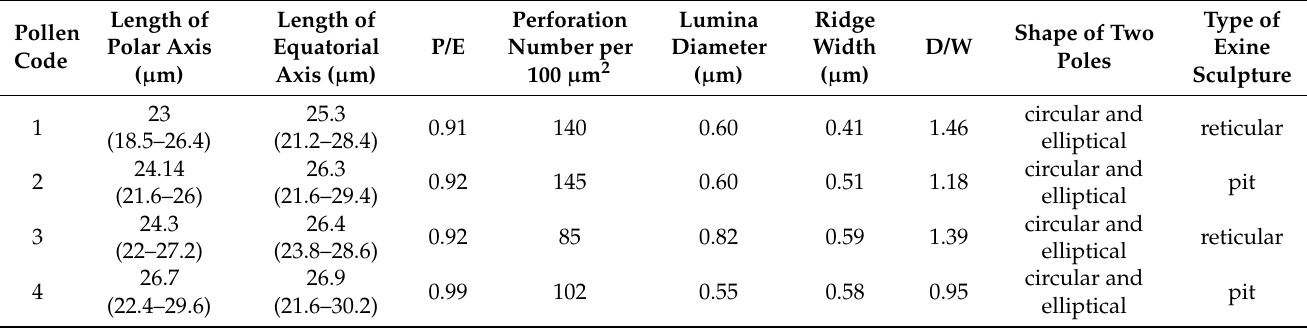
Table 2. Pollen grain characteristics of Paeonia lactiflora